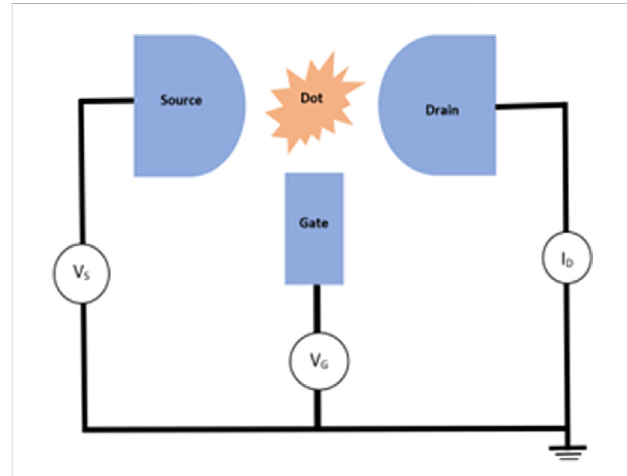
FIGURE 1 Schematic diagram of the tunnel coupling of quantum dot to the source and drain